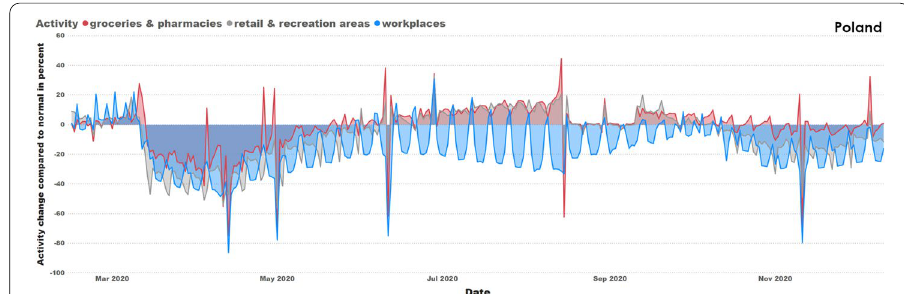
Fig. 20 Two main with summer work activity decrease